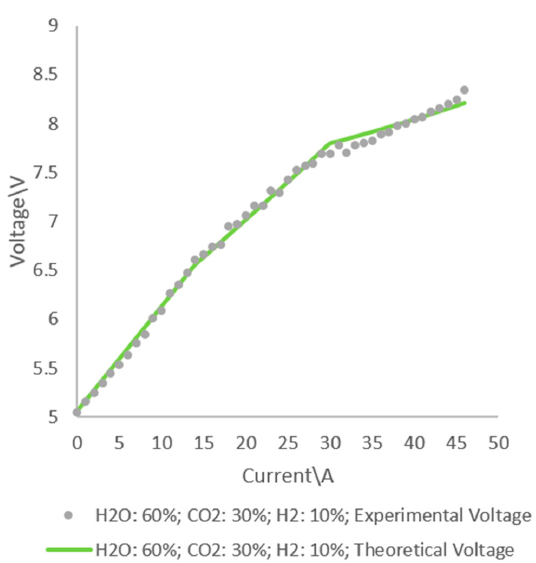
Figure 7. Comparison of the experimental and theoretical polarization curves of the SOE stack fed by the steam, CO 2 and H 2 gas mixture and air.